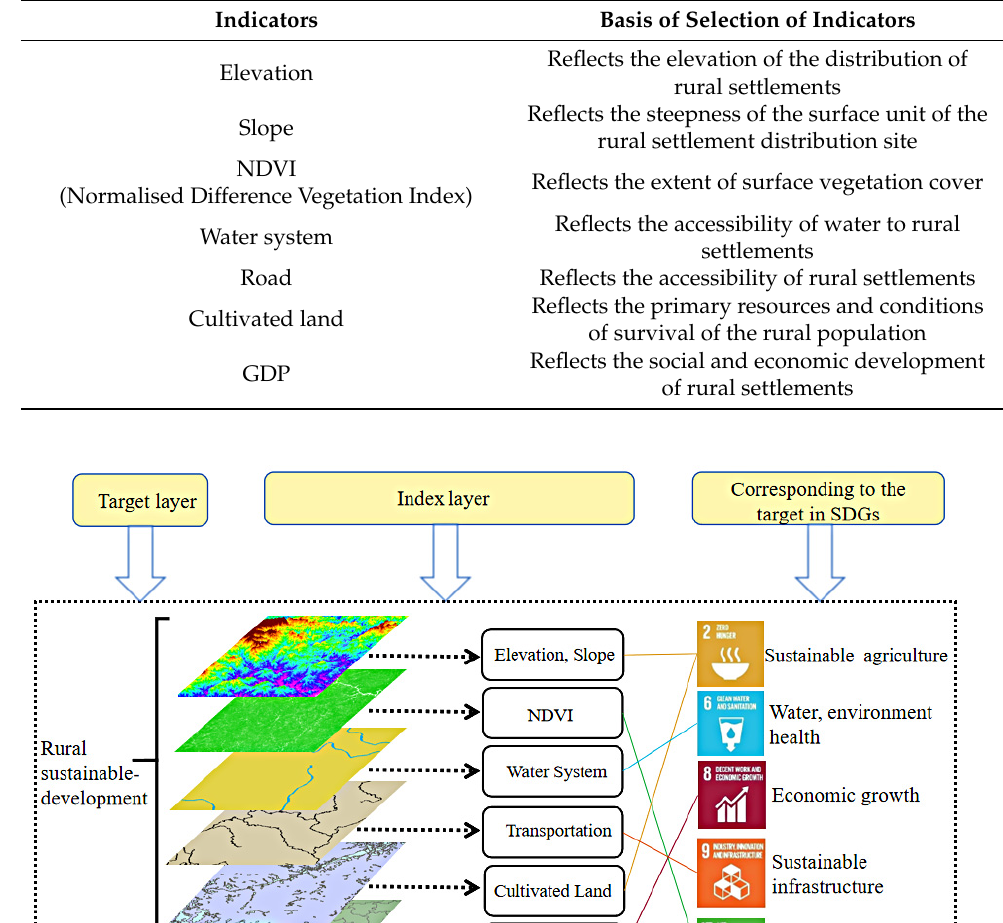
Table 1. Basis for selection of indicators.